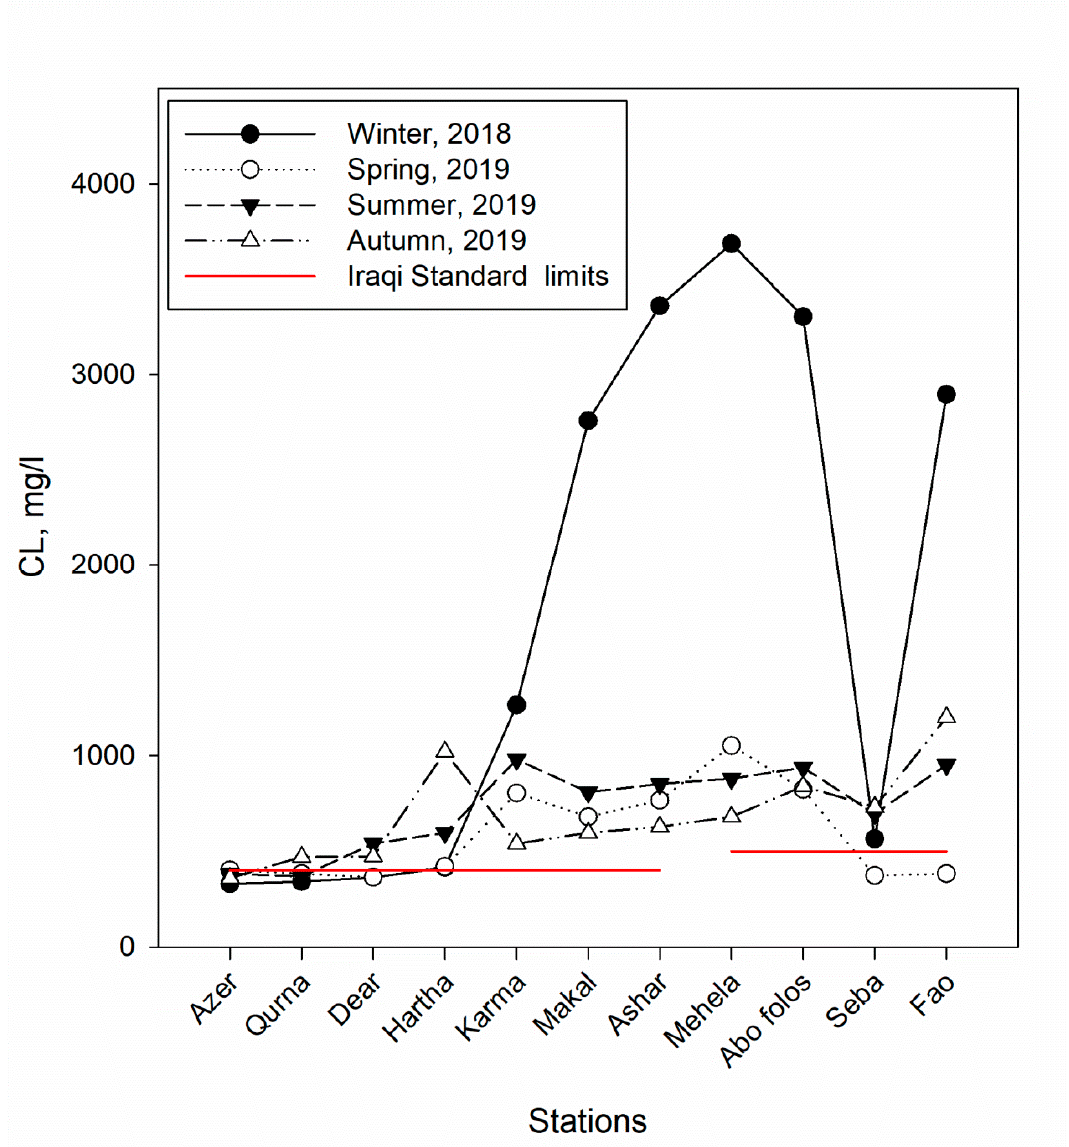
Figure 6. Chloride concentrations of the selected stations for different seasons during the study period.